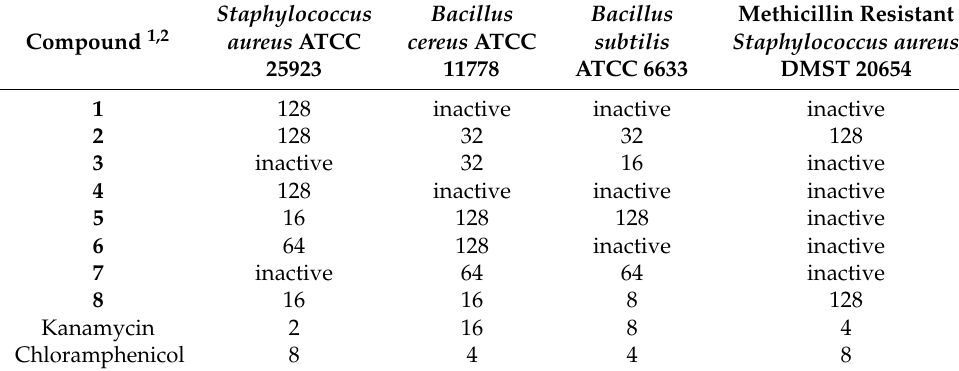
Table 4. Antibacterial activities of compounds 1 – 8 (MIC µ g/mL).